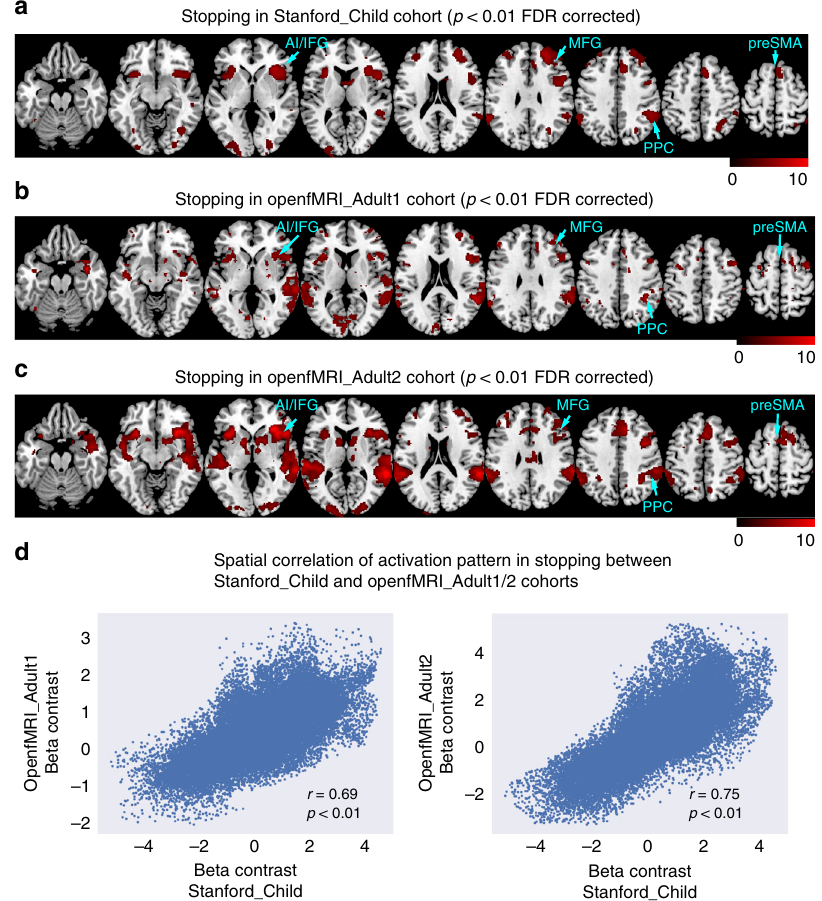
Fig. 3 Similarity of activation patterns in children and adults. a Stopping-related (SuccStop versus Go) activation of bilateral anterior insular (AI), right inferior frontal gyrus (IFG), middle frontal gyrus (MFG), pre-supplementary motor area (preSMA), and posterior parietal cortex (PPC) in children from the Stanford_Child cohort ( p < 0.01, FDR corrected). b , c The two adult cohorts (OpenfMRI_Adult1 and OpenfMRI_adult2) showed activation in similar brain regions including bilateral AI, right IFG, MFG, preSMA, and PPC in stopping. d Brain-wide activation patterns elicited by stopping in children were signi fi cantly correlated with activation patterns in two different adult cohorts. Source data are provided as a Source Data fi